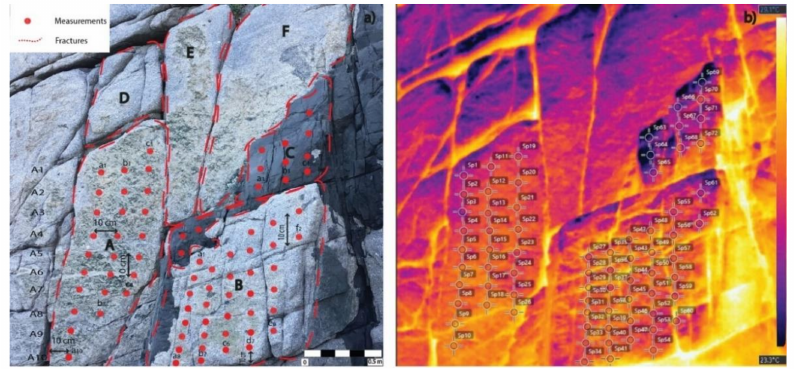
Figure 2. Acquisition scheme ( a ) in the field, where 10 rebound tests were performed at each point, and ( b ) in FLIR Tools software, where each point corresponds to a spot measurement within the thermogram. The image in ( b ) was acquired at